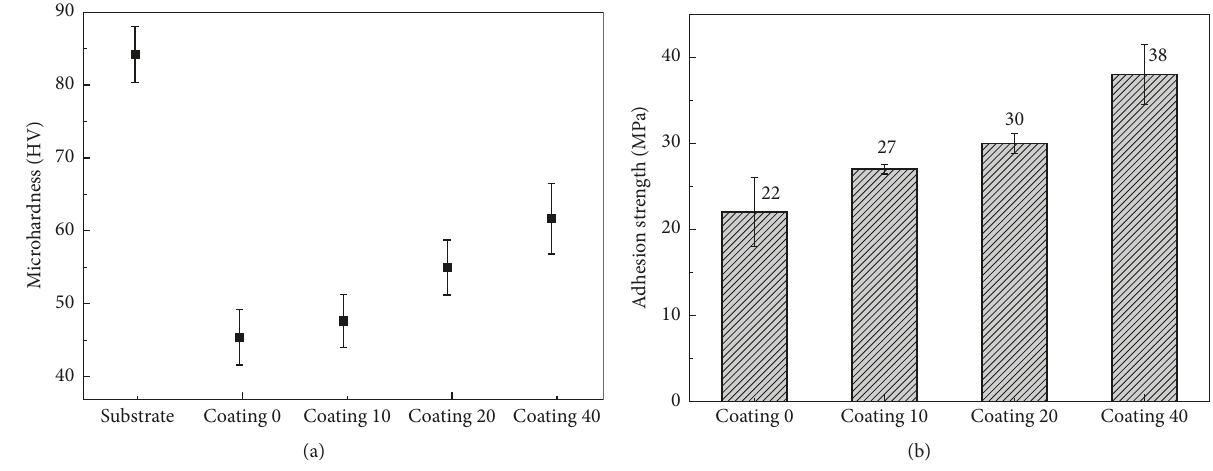
Figure 3: Microhardness (a) and adhesion strength (b) of the